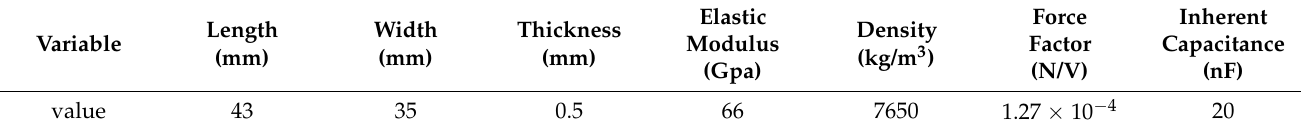
Table 3. Piezo-patch characteristics.